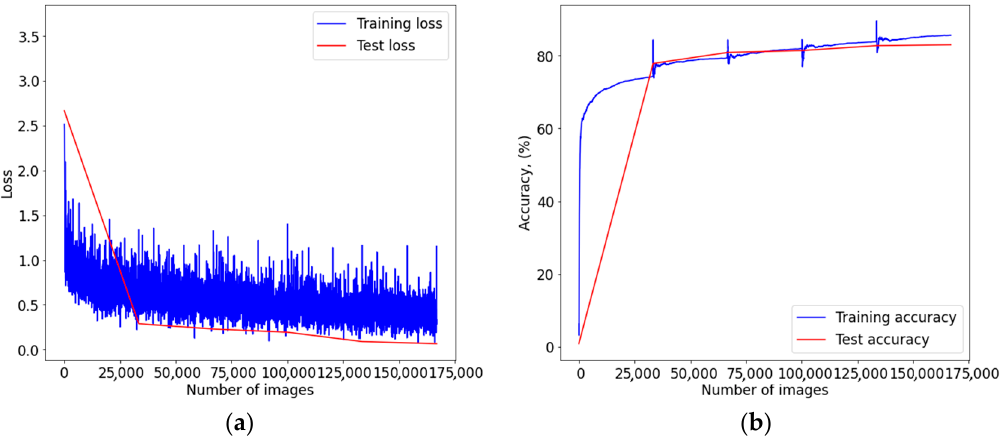
recognition accuracy.